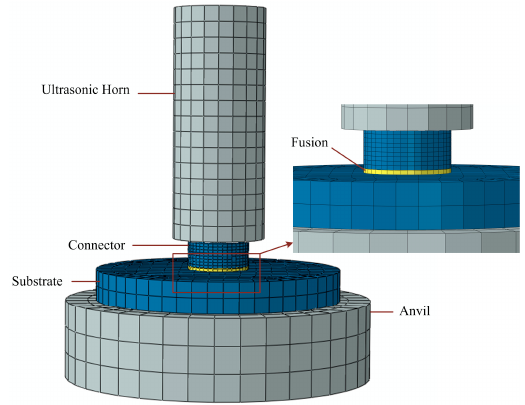
Figure 2. Finite element model corresponding to ultrasonic welding process. Table 1. Material parameters for steel and poly methyl methacrylate (PMMA) parts.